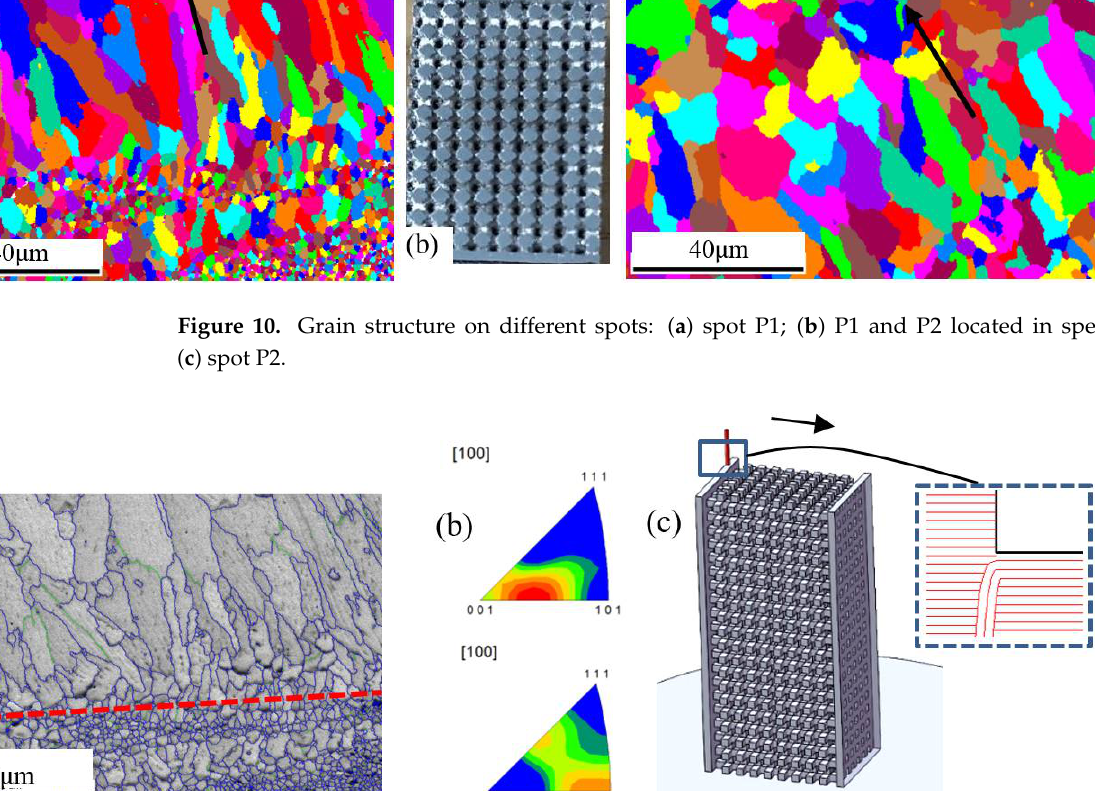
Figure 11. Grain structure of different parts: ( a ) first forming layer, ( b ) later forming layer, and ( c ) schematic diagram of forming process.